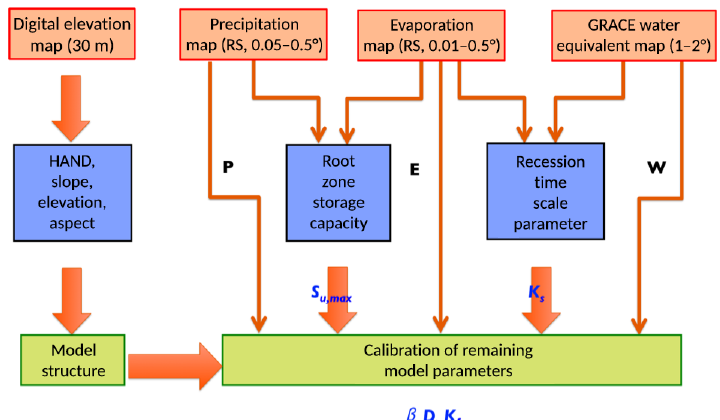
Figure 1. Flow diagram for prediction in ungauged